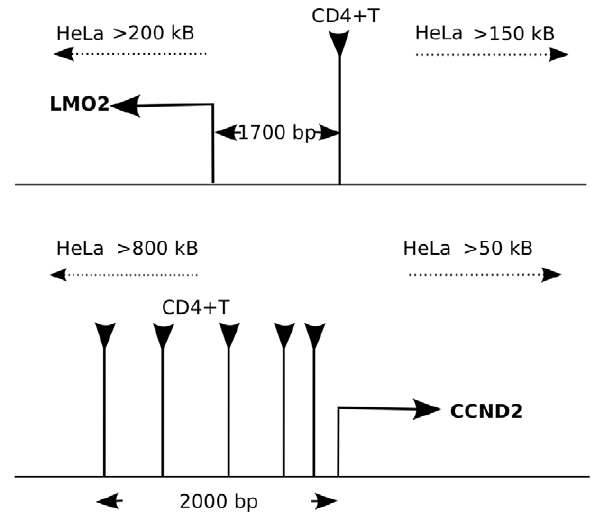
Figure 11. Cell type-dependence of supermarker density near the promoters of protooncogenes. ( A ) Schematic diagram of the region on human chromosome 11 flanking the promoter of the protooncogene LMO2 . In CD4 + T cells, a very prominent supermarker peak is found wi2kB of the TSS. According to supermarker density, the probability of MLV integration in this region is 1 in 10 5 . In HeLa cells, the nearest supermarker is found more . 150 kB upstream and the probability of MLV integration is 1 in 10 7 . ( B ) Schematic diagram of the region on human chromosome 12 flanking the promoter of the protooncogene CCND2 . In CD4 + T cells, a dense cluster of supermarker peaks is found wi2kB of the TSS, and the probability of MLV integration is 1 in 10 4 . In HeLa cells, the nearest supermarker is found . 50 kB downstream and the probability of MLV integration is 1 in 10 7 .